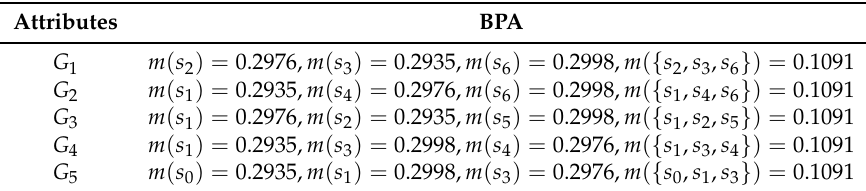
Table 13. BPAs of the attributes of A 2 .